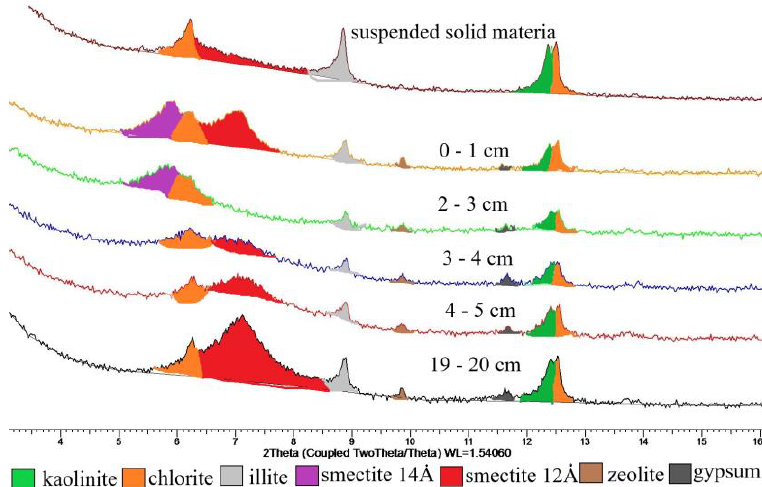
Figure 7. Variation of the clay mineral complex in the sediment core AMK-5454, the Cambridge Strait, the Franz Josef Land Archipelago.